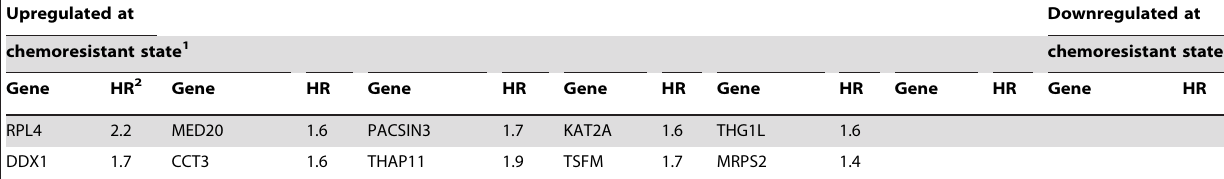
1 Sorted according to the increasing order of P value for TTP correlation. 2 The ratio of hazards of disease progression of 101 patients for a two-fold change in the gene expression level.